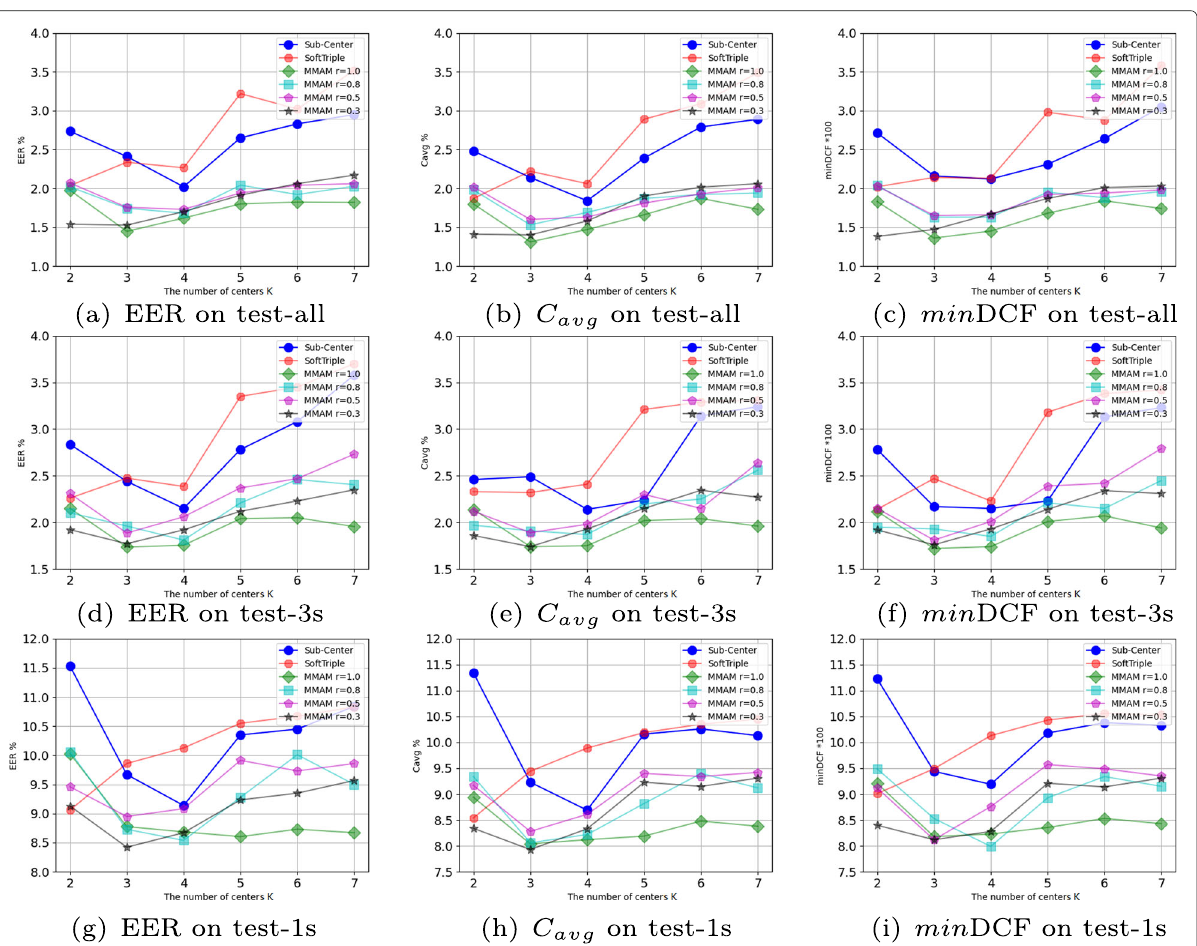
Fig. 6 Comparison with the existing types of multi-center loss under different number of centers ( K ) and four different scale factors ( r = 0.3, 0.5, 0.8,